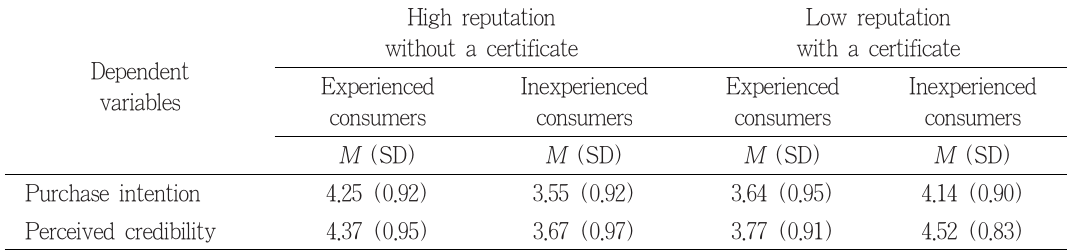
<Table 4> Purchase Intention and Perceived Credibility in Two Conditions of Inconsistent